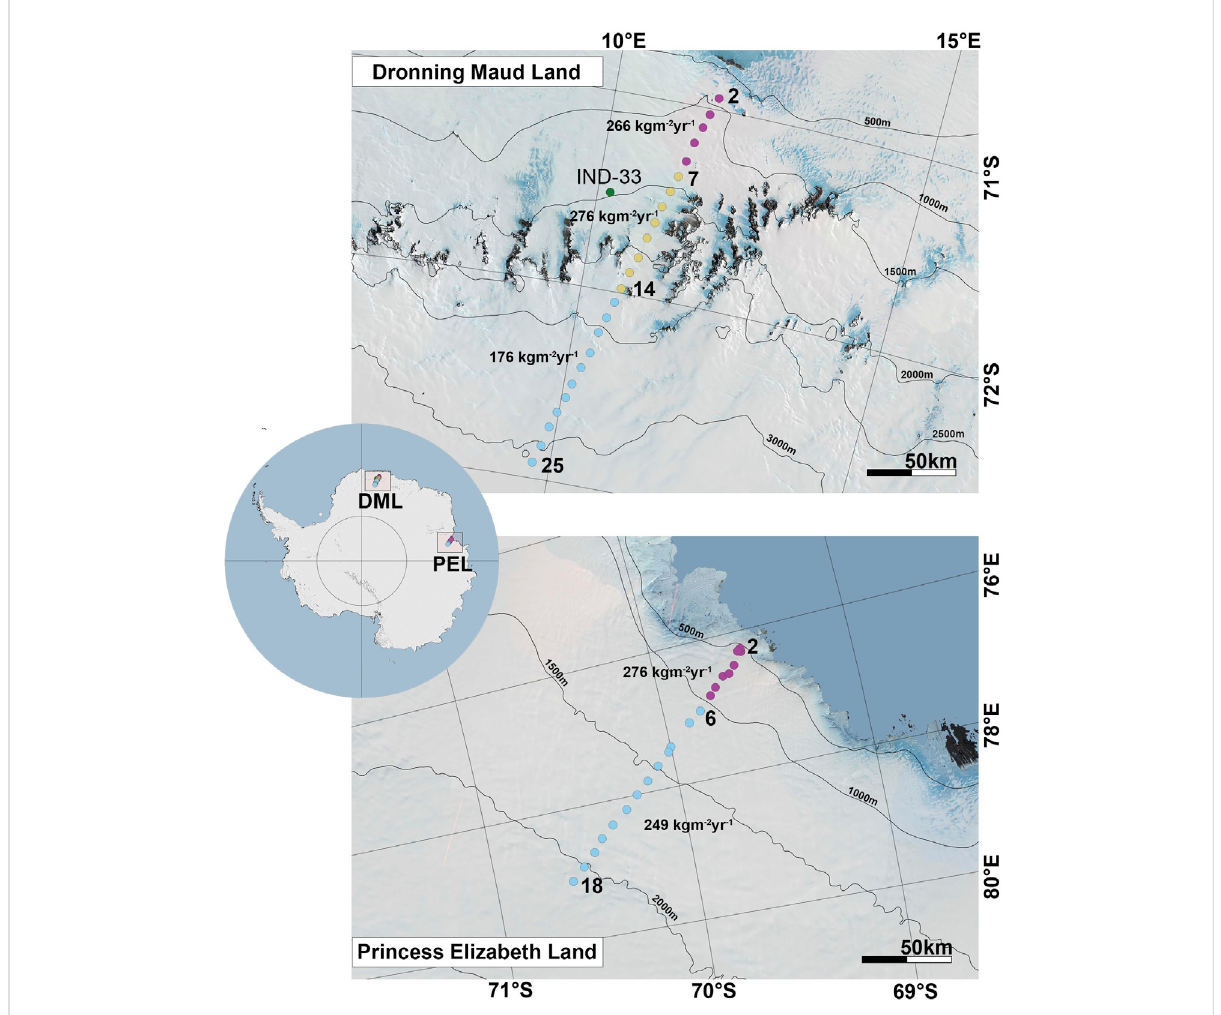
FIGURE 1 Study region showing sampling locations along the DML and PEL transects in East Antarctica. Color coded sampling locations indicate coastal (purple), mountainous (yellow) and inland (blue) regions of the transect. Mean snow accumulations in these respective regions are given in terms